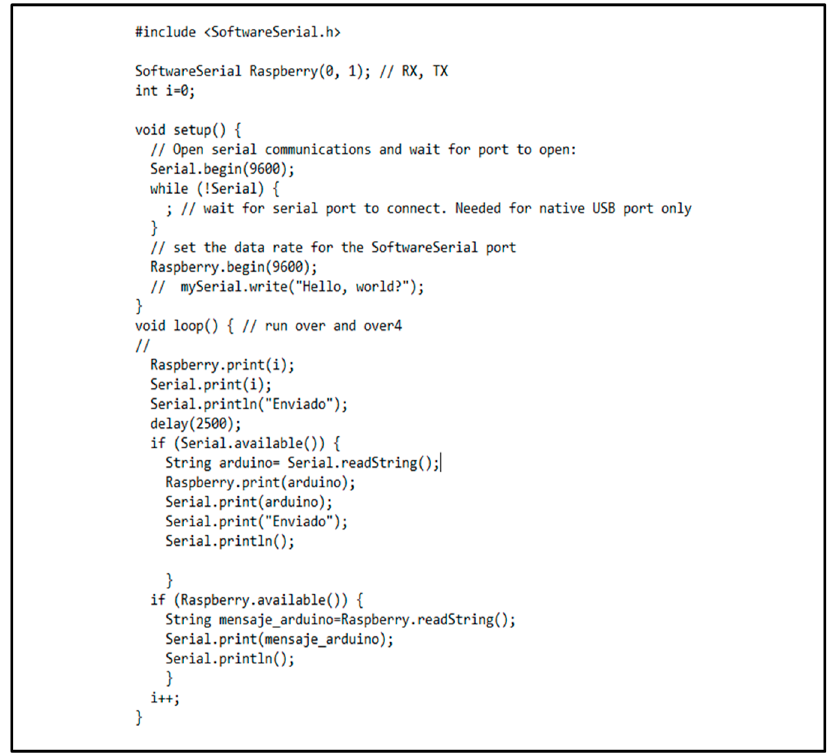
Figure A2. Arduino programming for XBee devices with ZigBee protocol .